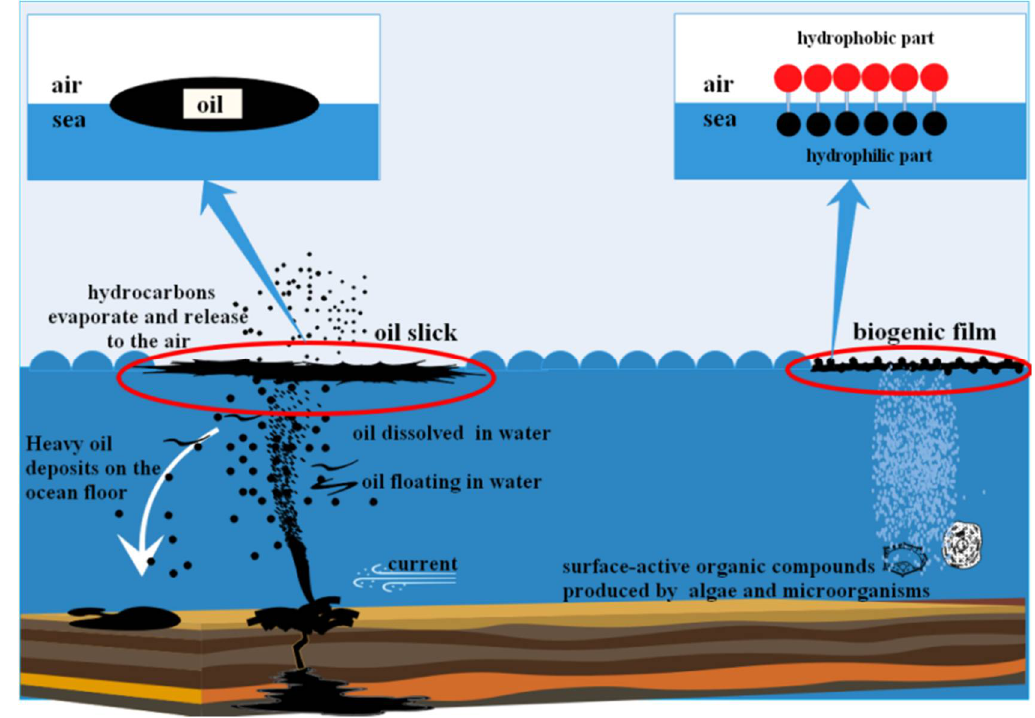
Figure 1. Schematic of natural oil seeps and biogenic slicks formed in the ocean environment. Table 1. Parameter properties of SAR data in two Cases.